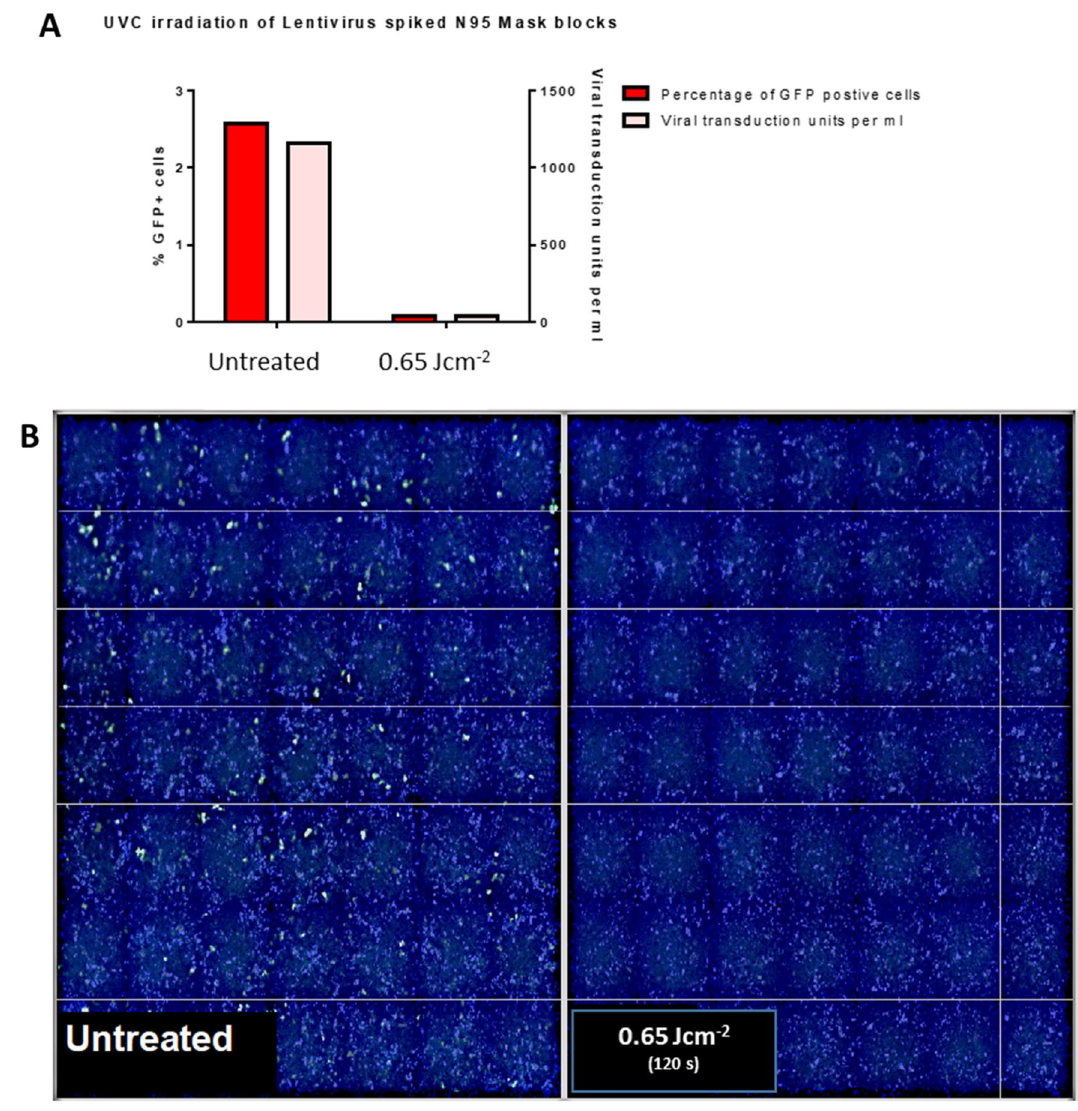
Figure 2. UVC exposure of N95 test coupon squares spiked with LV-EGFP indicated inactivation of lentivirus after treatment for a total of 120 s. N95 test coupon squares (2.5 cm 2 ) with all layers were incubated in infection media spiked with LV-EGFP for 15 min. The test coupons were then placed on open 10 cm polystyrene cell culture dishes 15.2 cm from the lamp. After warming up the lamp, the blocks were treated for 60 s per each side. Test coupons were left in infection media for 15 min, protected from light, at room temperature. 0.8 ml of the test coupon derived media mix was used from each condition to infect A549 cells. Cells were fixed with 4% paraformaldehyde, stained with DAPI and imaged using a Cellomics ArrayScan. ( A ) UVC treatment of N95 test coupons spiked with LV-EGFP indicates viral inactivation after 120 s of total exposure. GFP + cells and the total viral transduction units per ml of supernatant were assessed and data shown here are derived from two replicates. ( B ) Fluorescence microscopy analysis of infected A549 cells indicate viral inactivation. Supernatants derived from treated or untreated 3 M-N95 test coupons were used to infect A549 monolayers. 48 h post infection, cells were fixed and stained for nuclei using DAPI current SARS-CoV-2 pandemic UVC air and surface borne decontamination can be deployed more generally, for example to decontaminate public spaces. Here, we evaluated a germicidal UVC 254 nm irradiation system as a potential tool to decontaminate respirators with the aim of assisting their safe reuse. We first characterized the device by obtaining the dose response parameters as well as identifying the impor- tance of the positioning of the respirators which are to be sterilized to obtain the most efficient decontamination setting (Fig. 1C,D,E). The prototype derivative we had was first used to test the germicidal potential, using a lipid enveloped 3rd generation lentivirus as a model virus under BSL-2 containment. The data suggested robust reduc- tion of lentivirus that were infused within the N95 test coupons upon UVC 254 nm treatment for a total 120 s (Fig. 2; 1.53 Log 10 reduction). By taking the above data into consideration, we then evaluated a time and dose dependent UVC irradiation protocol for the decontamination of N95 Respirator test coupons spiked with live